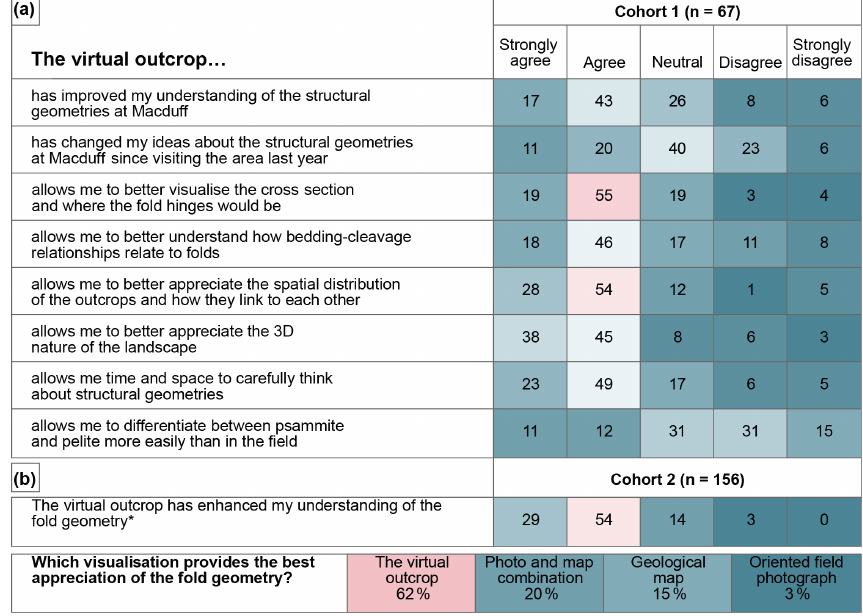
Figure 5. Responses by participants to questions on the value of virtual outcrops to enhance learning and understanding. (a) Responses by Cohort 1 to eight statements given in column 1. (b) Responses by Cohort 2 to a single question on the enhancement of understanding and which of the representations gives the best visualisation of the fold geometry. Responses are given as percentages to the possible answers; see Fig. 4 for the colour